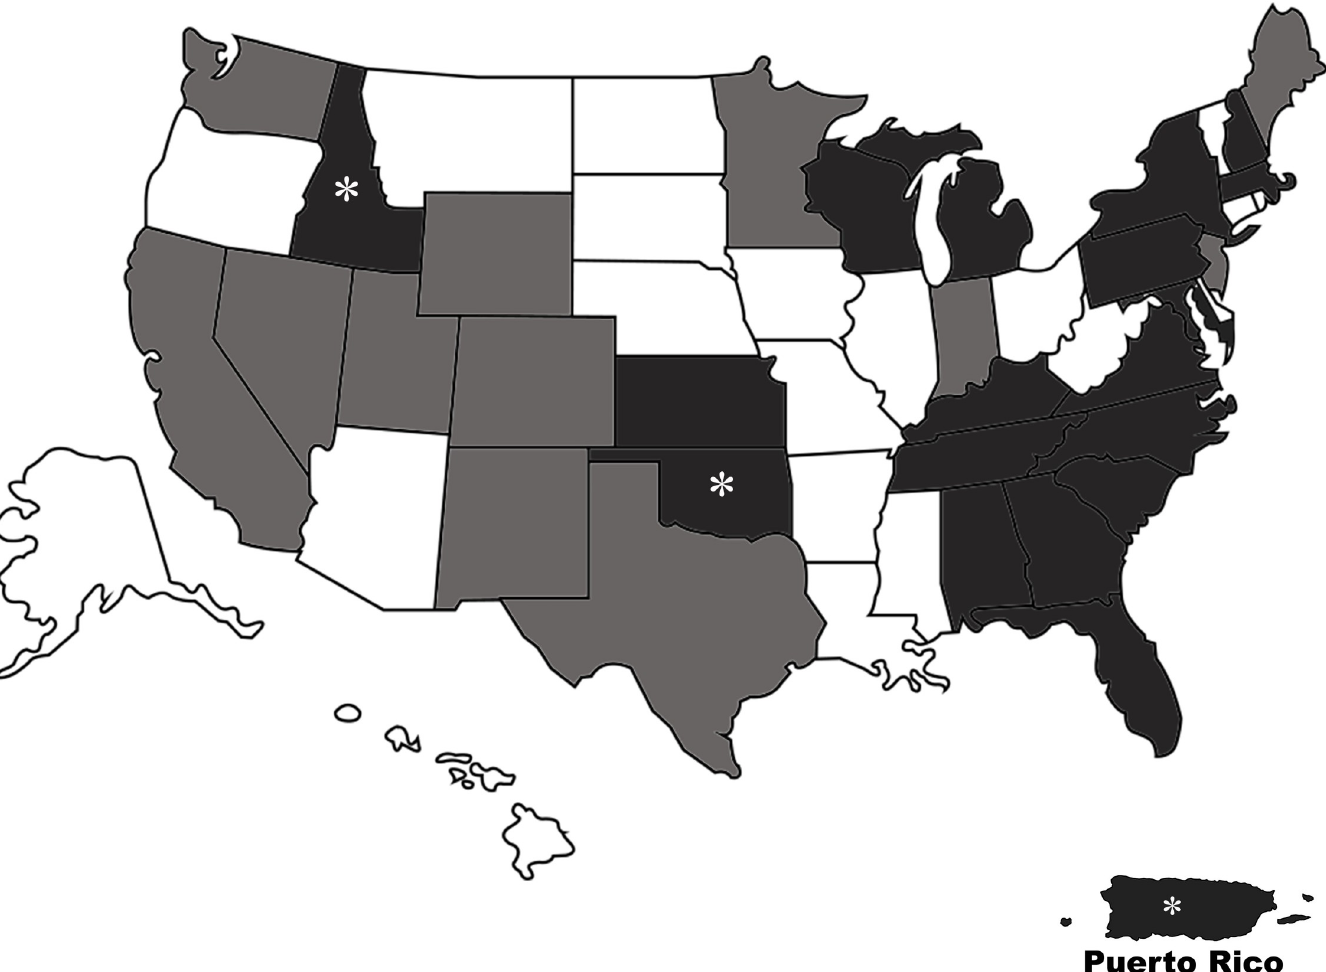
Fig 1. Spatial distribution of Ophidiomyces ophiodiicola detection in snakes on military installations sampled in 2018. White = states not sampled, light grey = states with no detection of O . ophiodiicola , dark grey = states detected with O . ophiodiicola . White asterisks indicates a state/territory identified with O . ophiodiicola for the first time in this